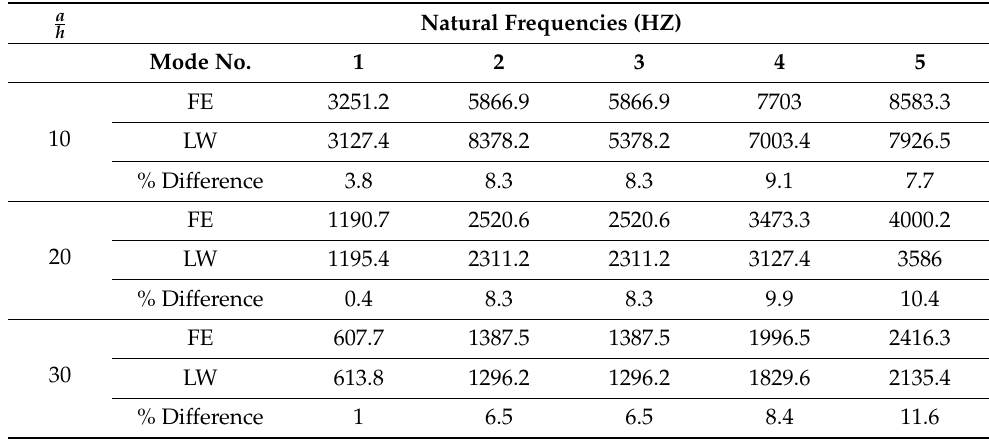
Table 8. Comparison of frequencies (HZ) based on LT and those FE findings for various ( a/h ).